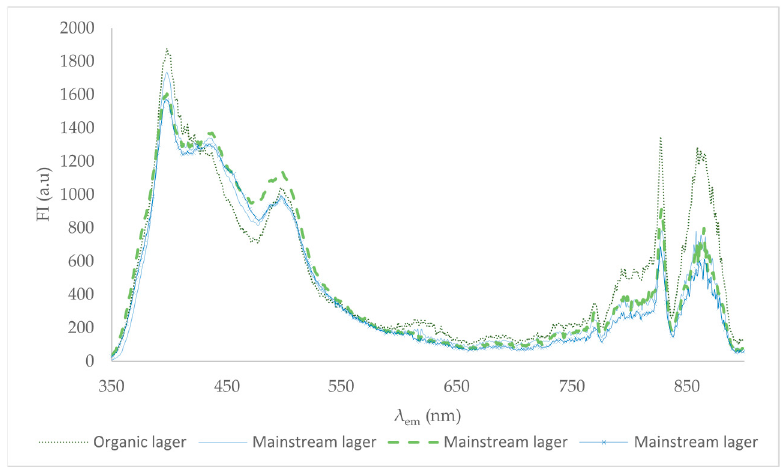
Figure 4. The emission spectra of select beers showing the differences between the organic lager (O22) and mainstream lager beers (D6, E9 and P23).